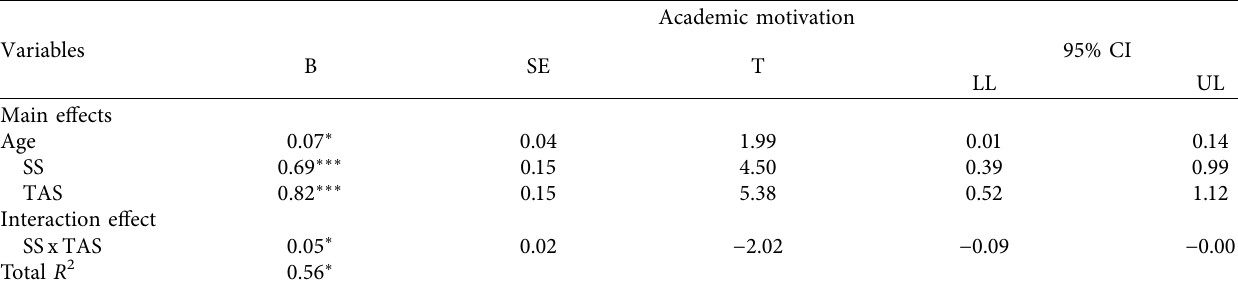
Table 3: Moderating effect of teachers’ academic support on the relationship of students’ satisfaction with online learning and academic motivation ( N � 406).